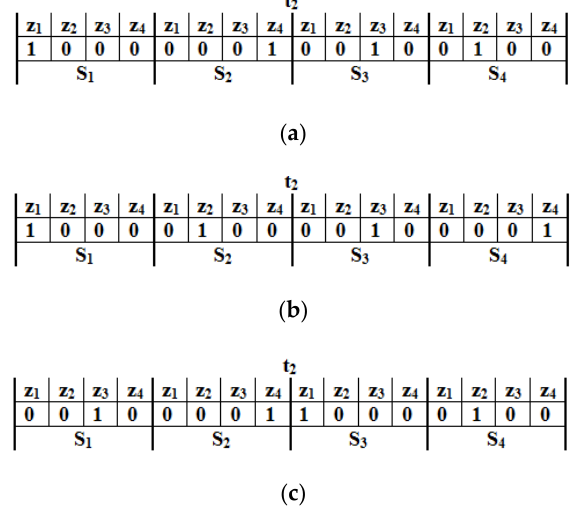
Figure 7. The movement operation during the time interval, t 2 under various parameter combinations ( a ) Case 1, ( b ) Case 2, and ( c ) Case 3.